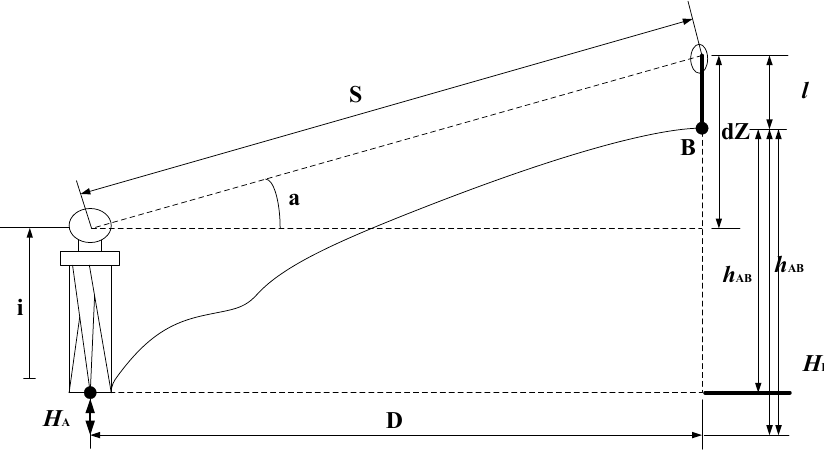
Figure 13. Principles of measurement method.